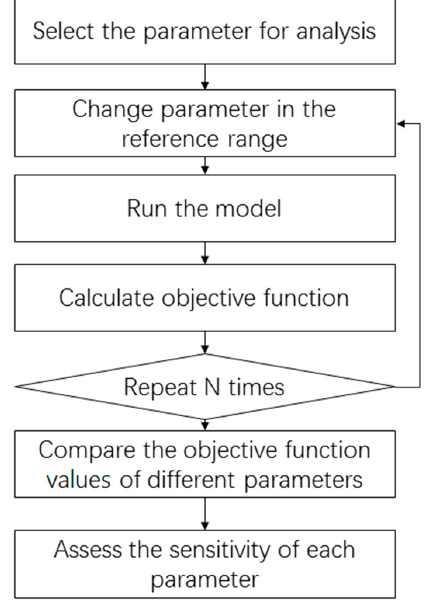
Figure 1. Procedure of the multi-parameter sensitivity analysis.